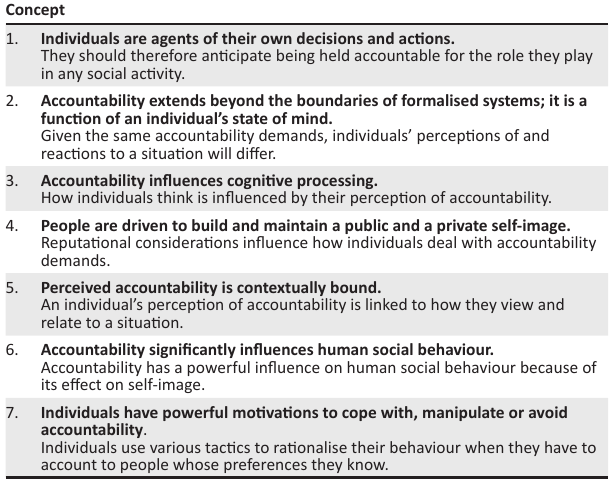
TABLE 1: Literature-derived accountability concepts.